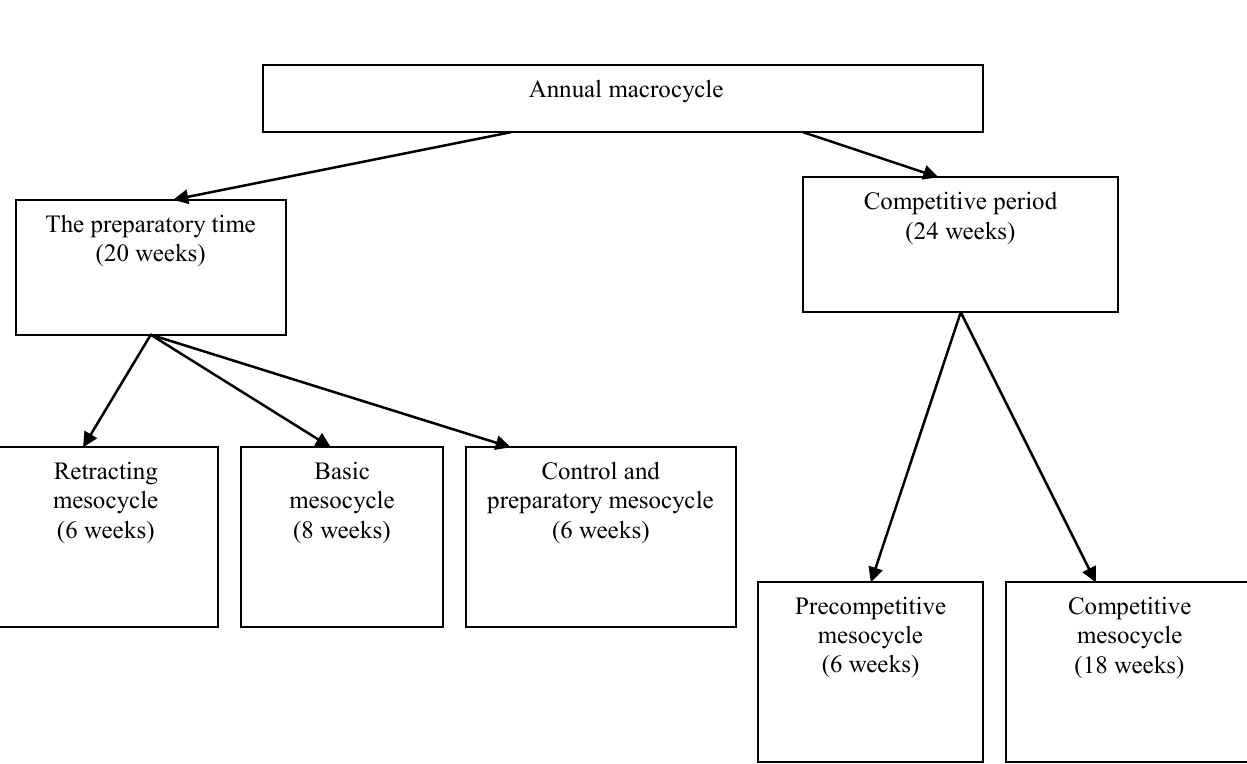
Figure 1. The annual structure of the lightweight rowers training process